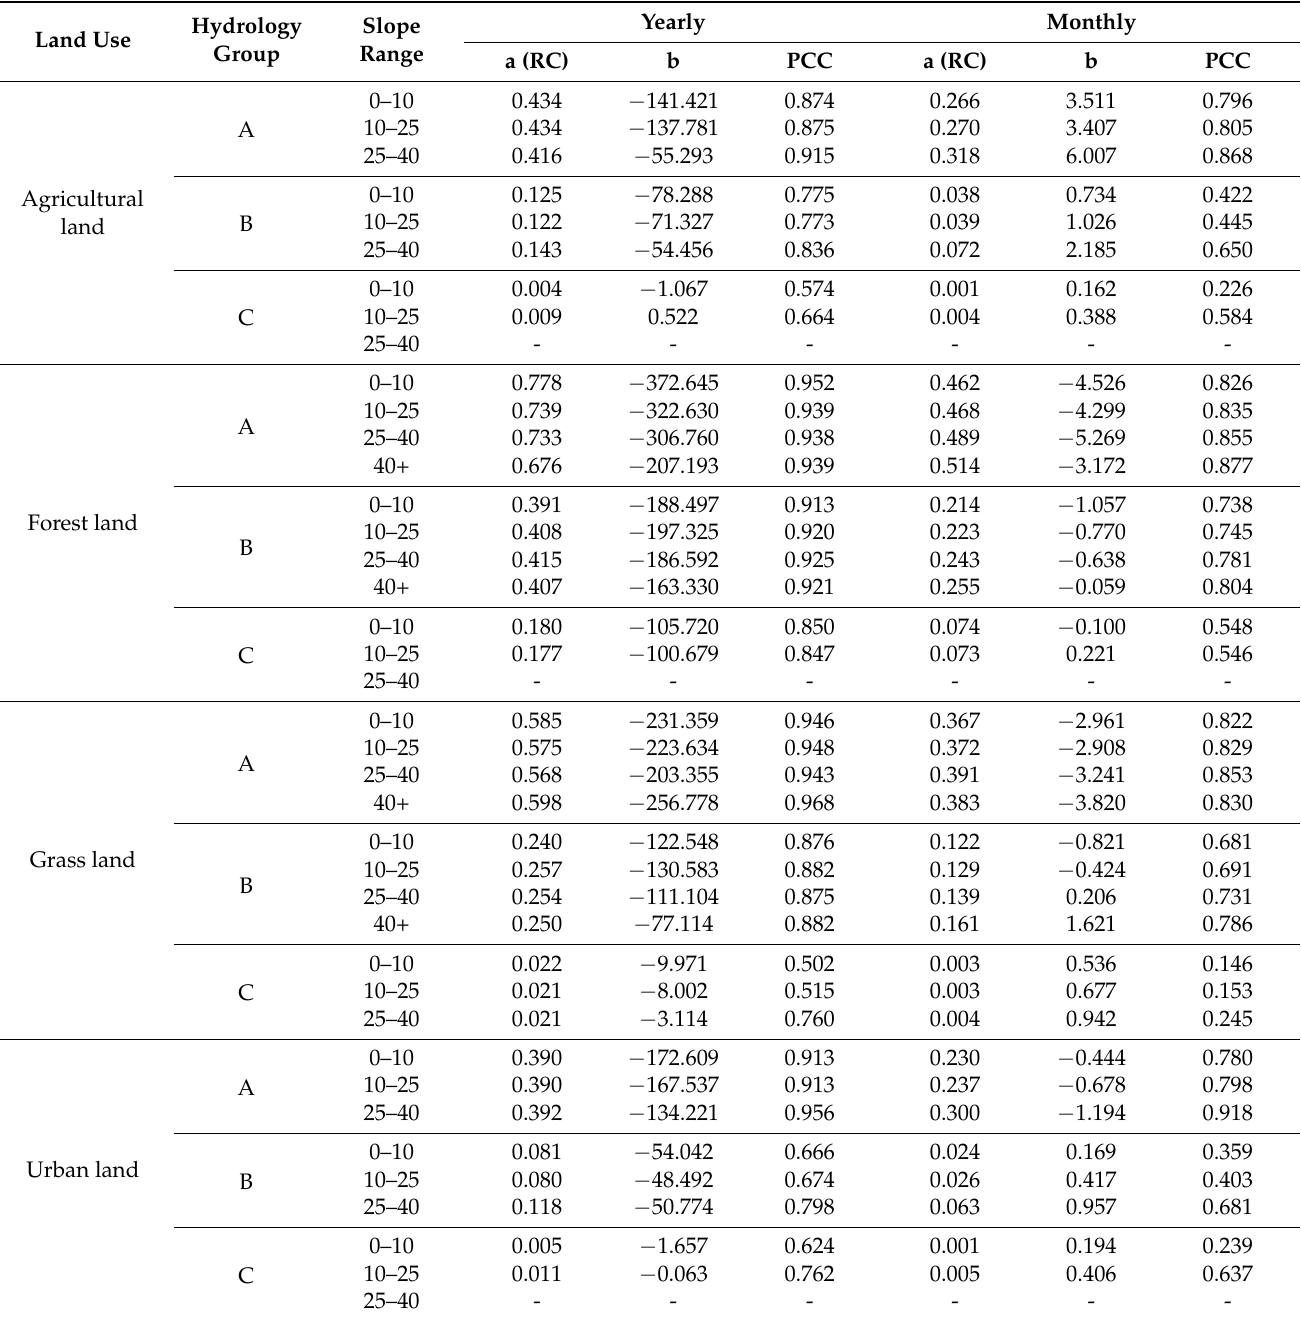
Table 3. The PPCs and RC for precipitation and baseflow for different combinations of land use, hydrology group, and slope range. a and b are the coefficient of the equation “Baseflow = a * Precipitation + b” established for each combination of land use, hydrology group, and slope